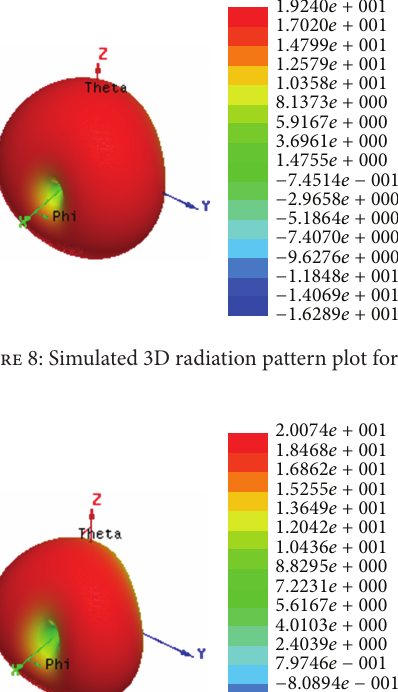
Figure 5: S 11 (dB) simulated and measured plot.